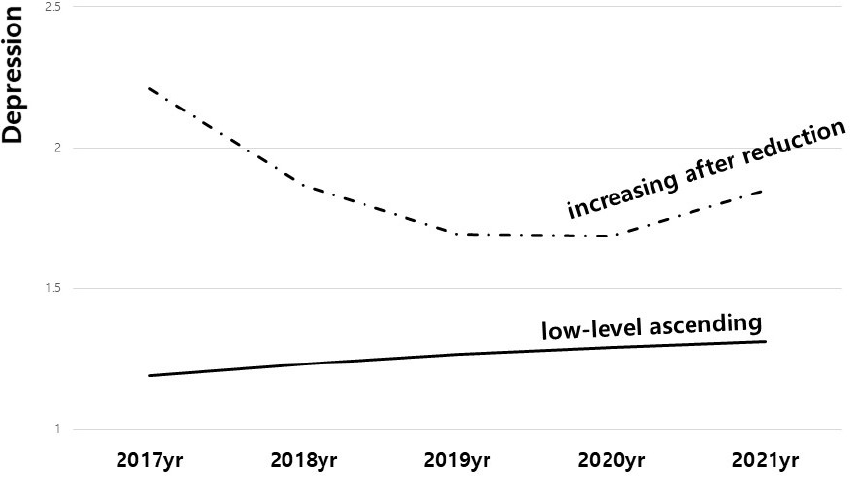
Figure 1. Estimation of Depression Change Types.